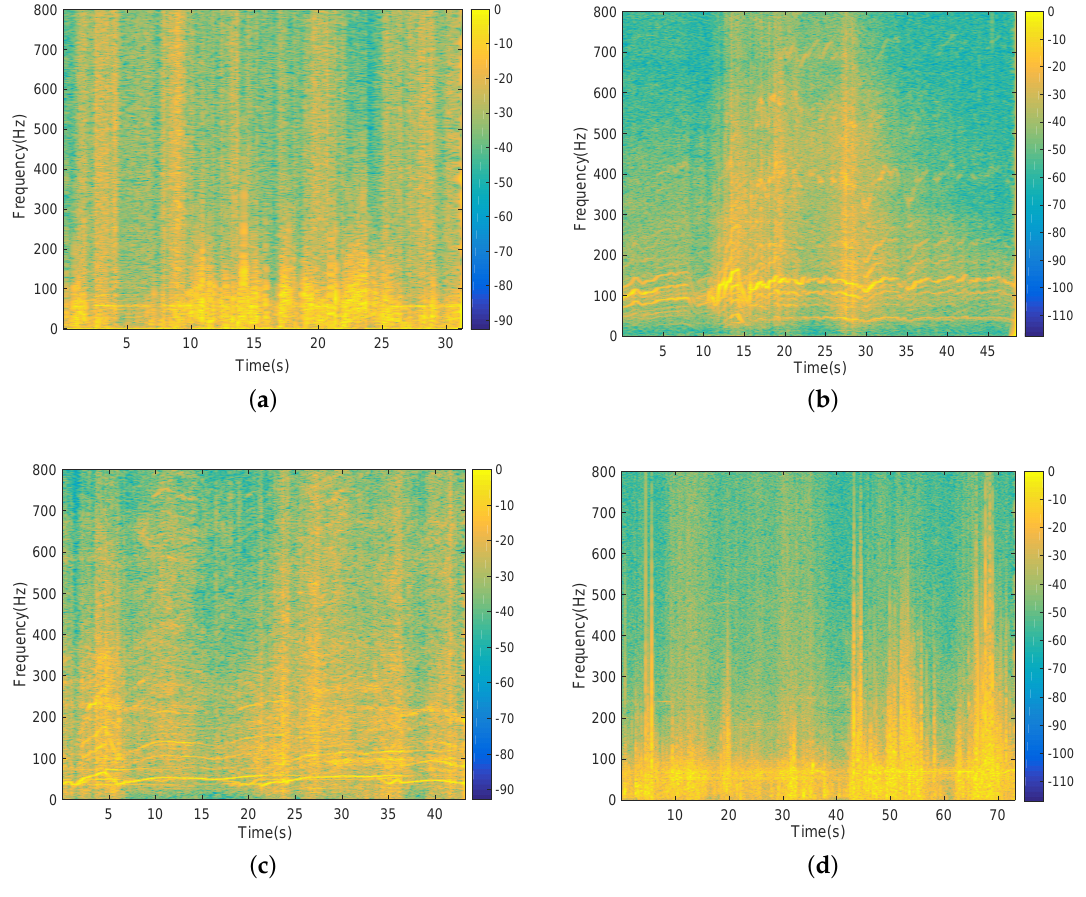
Figure 5. Spectrums of acoustic signals collected in Nanjing. ( a ) Spectrum of a noise signal; ( b ) Spectrum of a tracked vehicle (TV) signal; ( c ) Spectrum of a truck signal; ( d ) Spectrum of a car